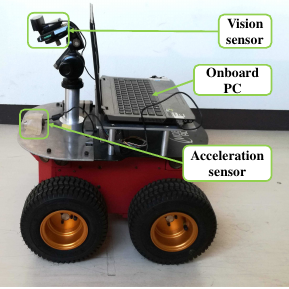
Figure 3. Pioneer 3AT hardware